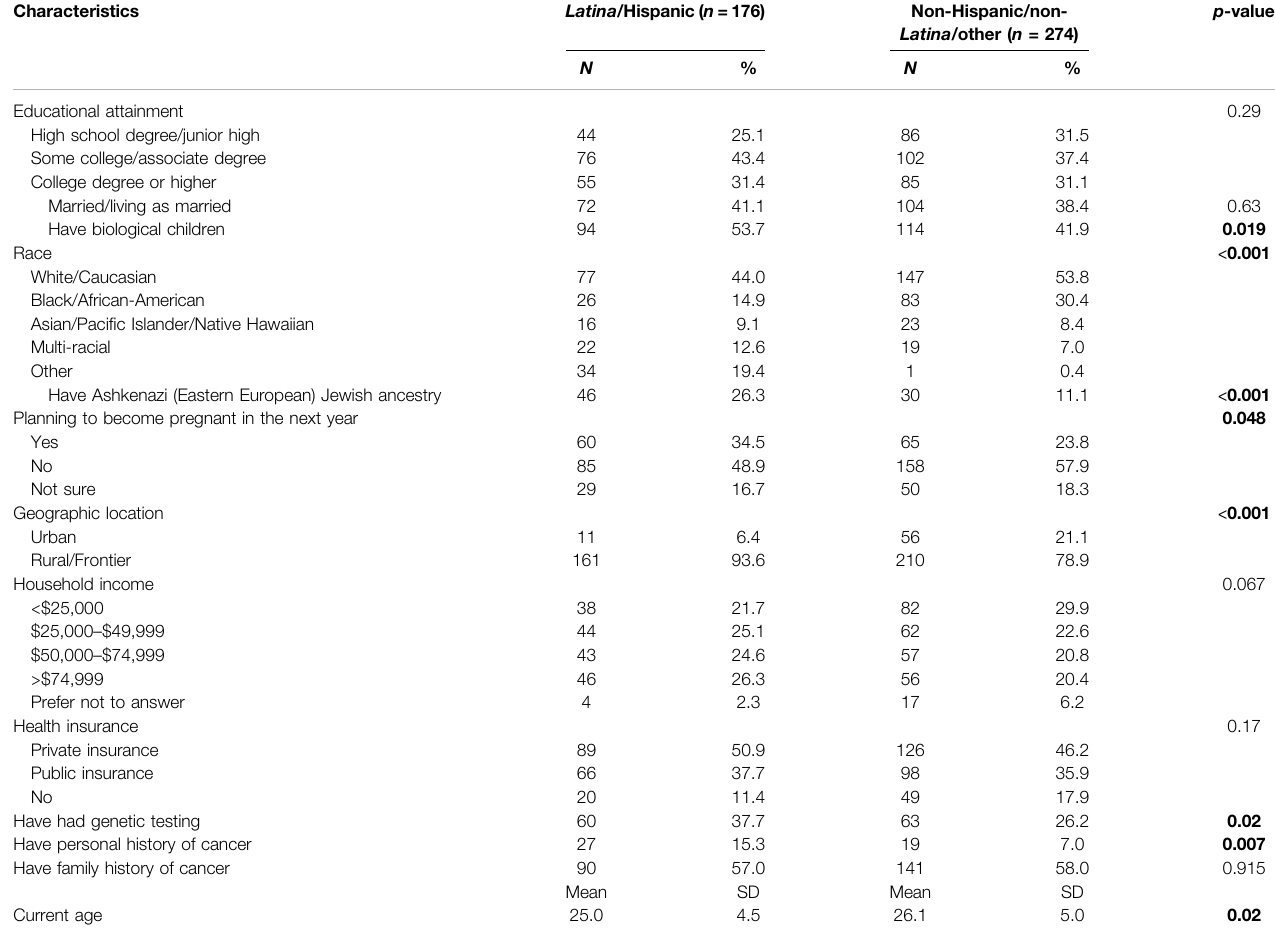
TABLE 1 | Sociodemographic characteristics of 450 female respondents by ethnicity.